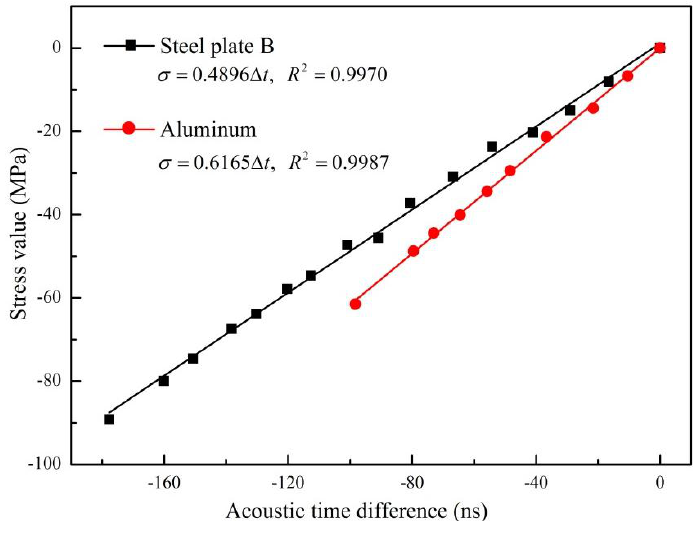
Figure 8. Fitting line between stress and TOF of steel plate B and aluminum plate.